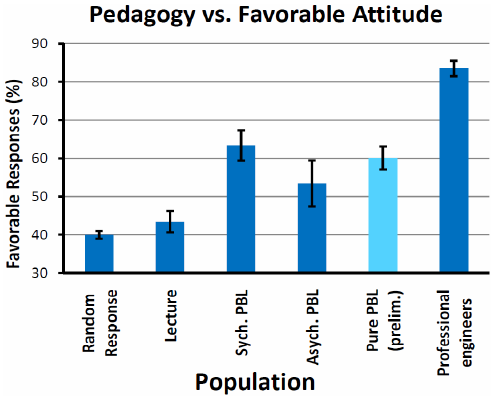
Figure 2. Bar chart representation of average scores from the Engineering Problem Solving